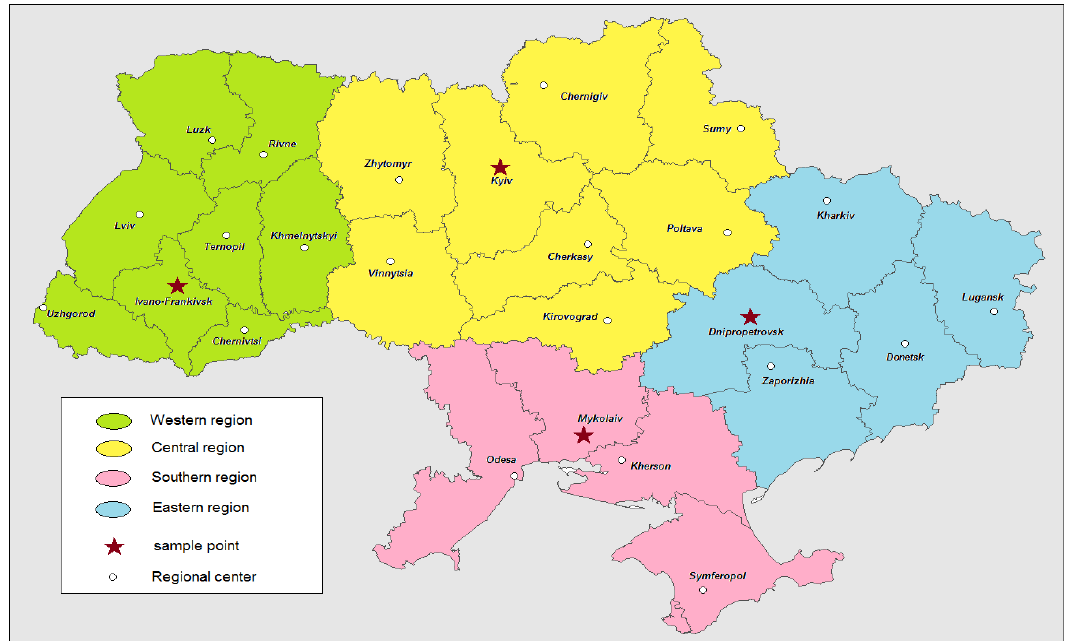
Figure 2. Location of the sampling points (MapInfo